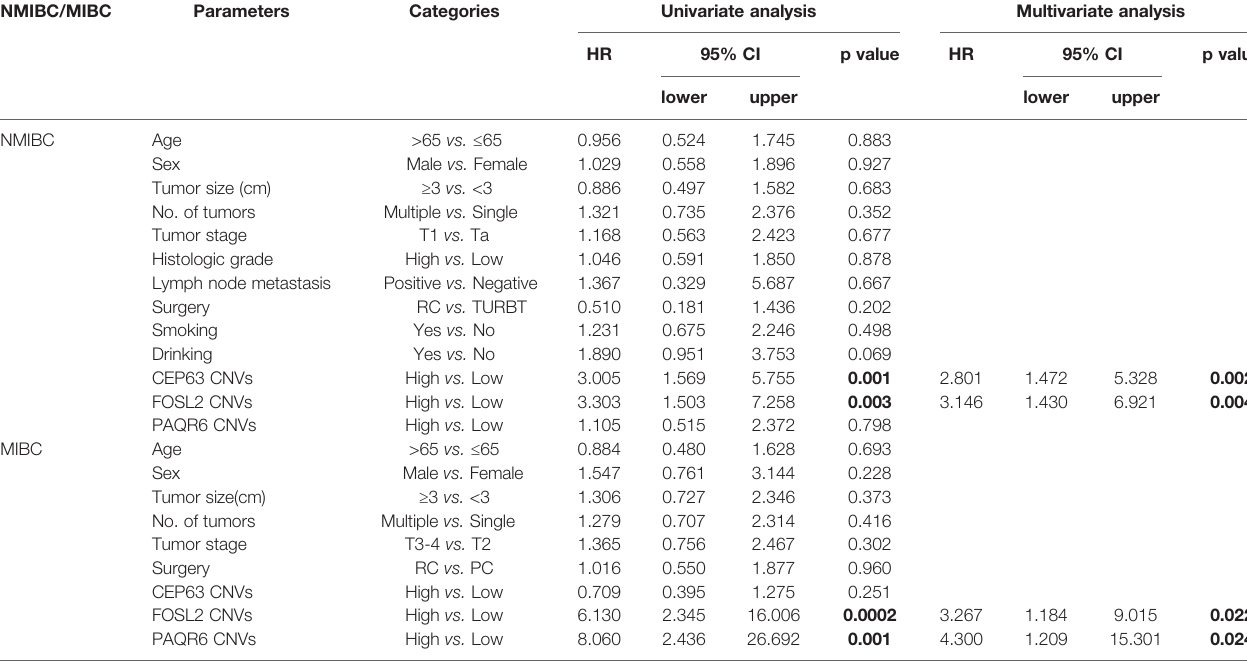
TABLE 5 | Univariate and multivariate Cox proportional hazard regression analysis for DFS prediction in NMIBC and MIBC patients.